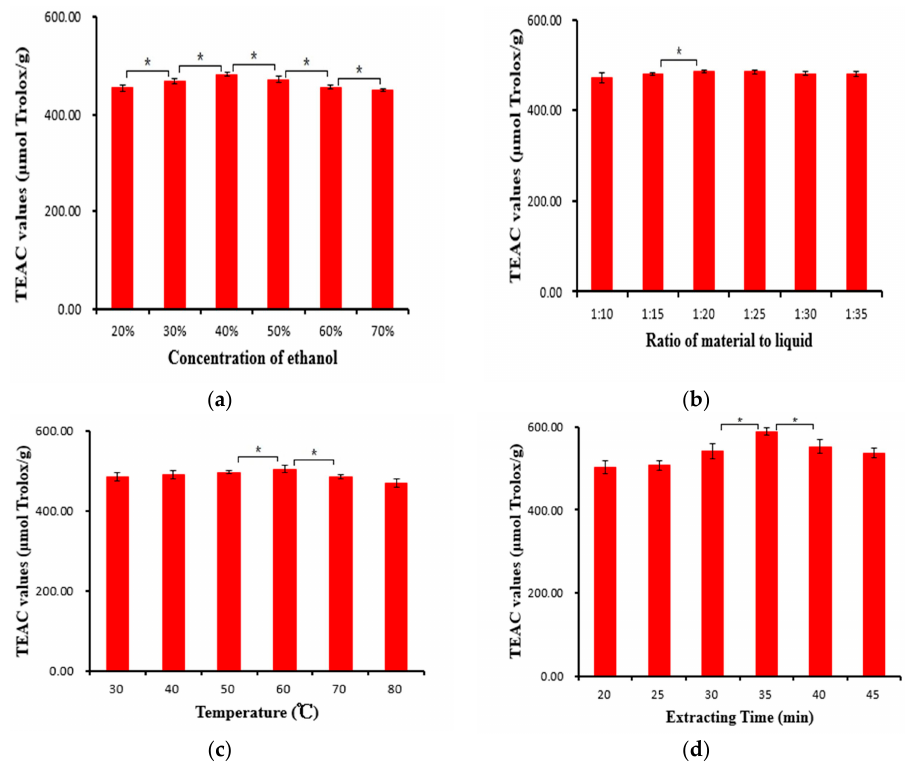
Figure 1. Effects of ethanol concentration ( a ); ratio of material to liquid ( b ); extracting temperature ( c ) and extracting time ( d ) on the extraction efficiencies. Note: * Significant difference ( p < 0.05).